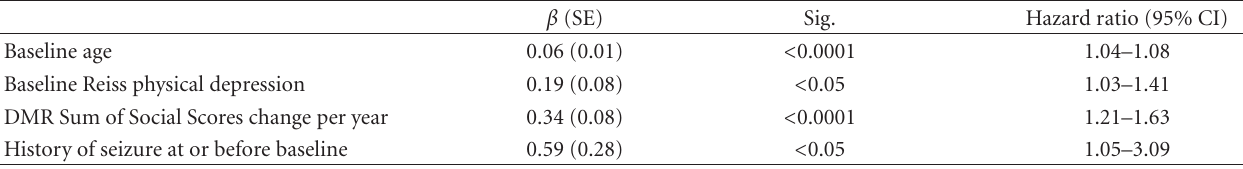
Table 6: Multivariate Cox regression analysis of mortality, as of July 2011